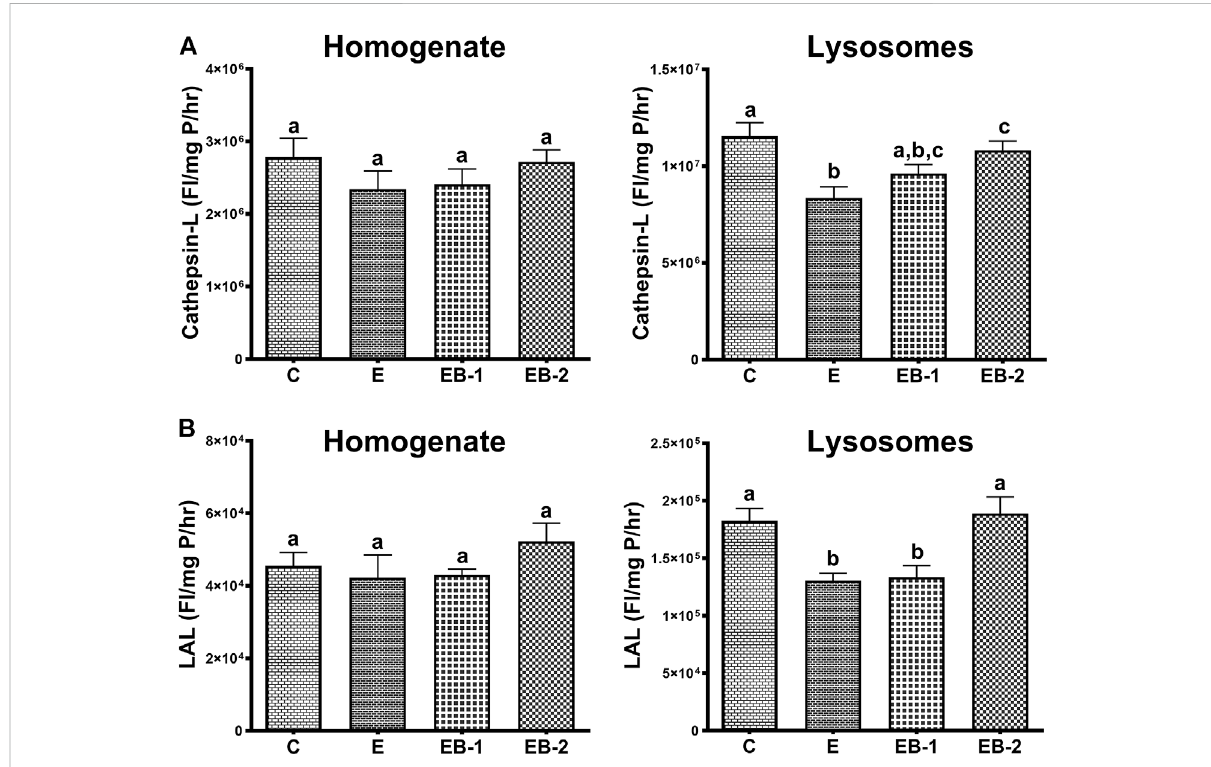
FIGURE 9 (A) Cathepsin-Land (B) LALactivitiesinthehomogenateand